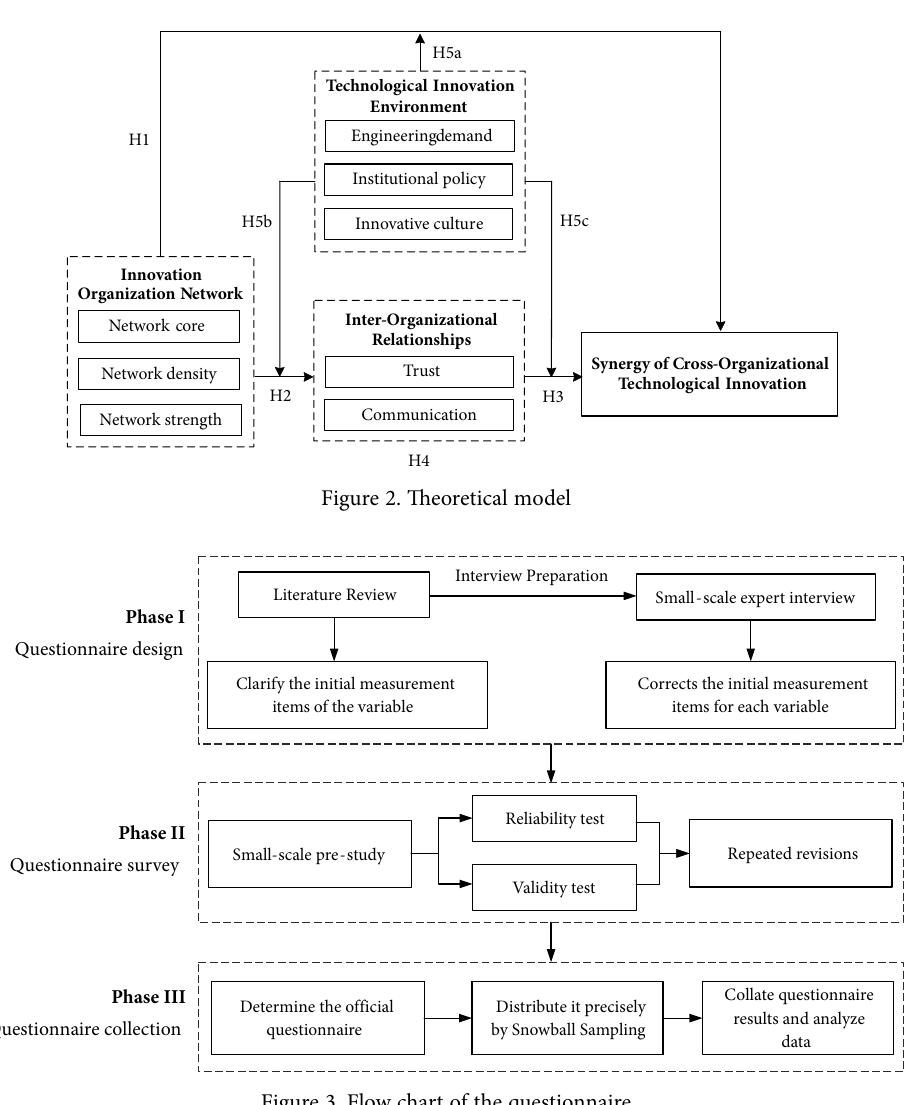
Figure 3. Flow chart of the